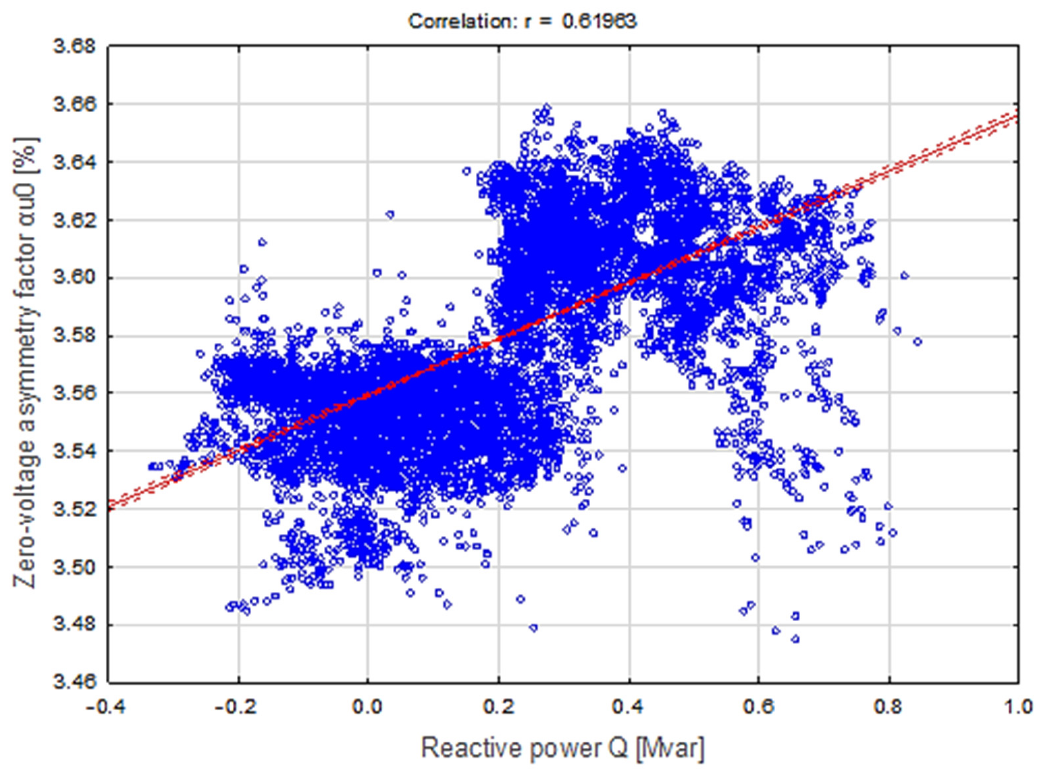
Figure 10. Dependence diagram of the zero-voltage asymmetry factor ( α u0% ) on the reactive power of the load (Q), determined during field tests.